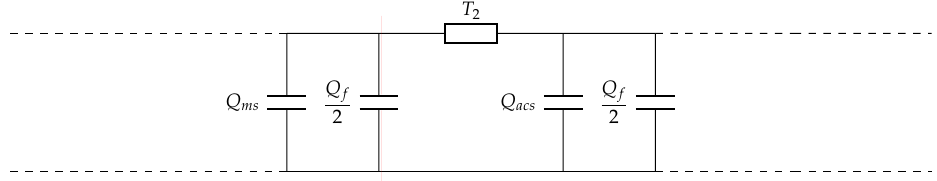
Figure 11. Transient representation of thermal parameters for